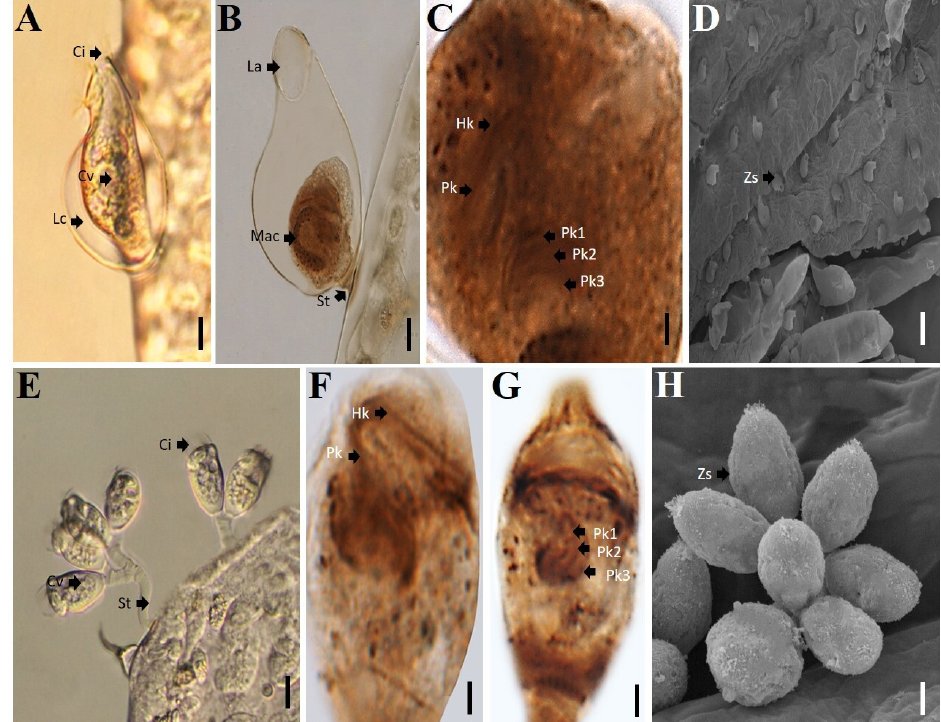
Figure 1. Ciliate epibionts in gills. ( A – D) . Cothurnia variabilis . ( A , B ). Detail of cell. ( C ). Oral ciliature after protargol impregnation. ( D ). Detail of cell in SEM. ( E – H ). Epistylis gammari . E. Colony attached to gills. ( F , G ). Oral ciliature after protargol impregnation. ( H ). Detail of the colony in